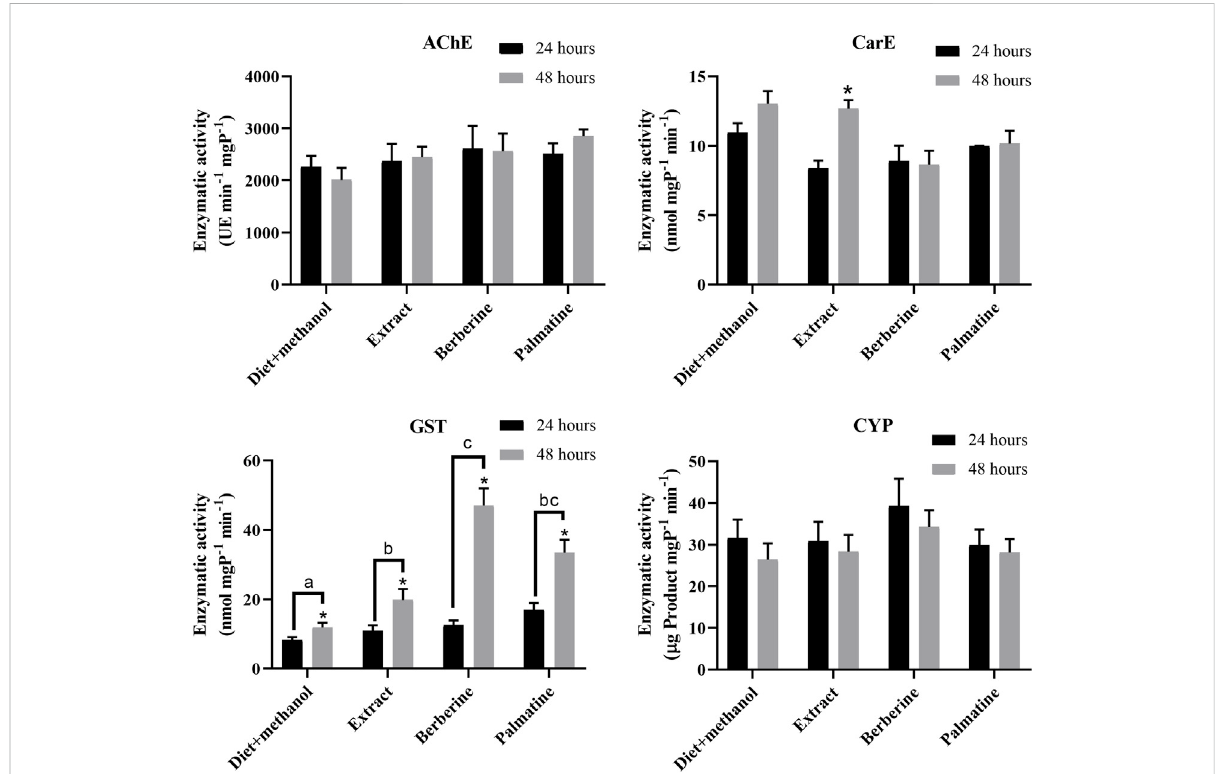
FIGURE 1 Enzymatic activity measured for carboxyl esterases, acetylcholinesterase, glutathione-S-transferase and cytochrome P450 during 24 and 48 h against B.microphylla extract,berberine,palmatineanddiet+methanol(negativecontrol).Differentlettersindicatestatisticallysigni fi cantdifference among treatments based on one-way ANOVA analysis. Asterisk (*) indicates statistically signi fi cant difference between 24 and 48 h for each treatment based on t -test